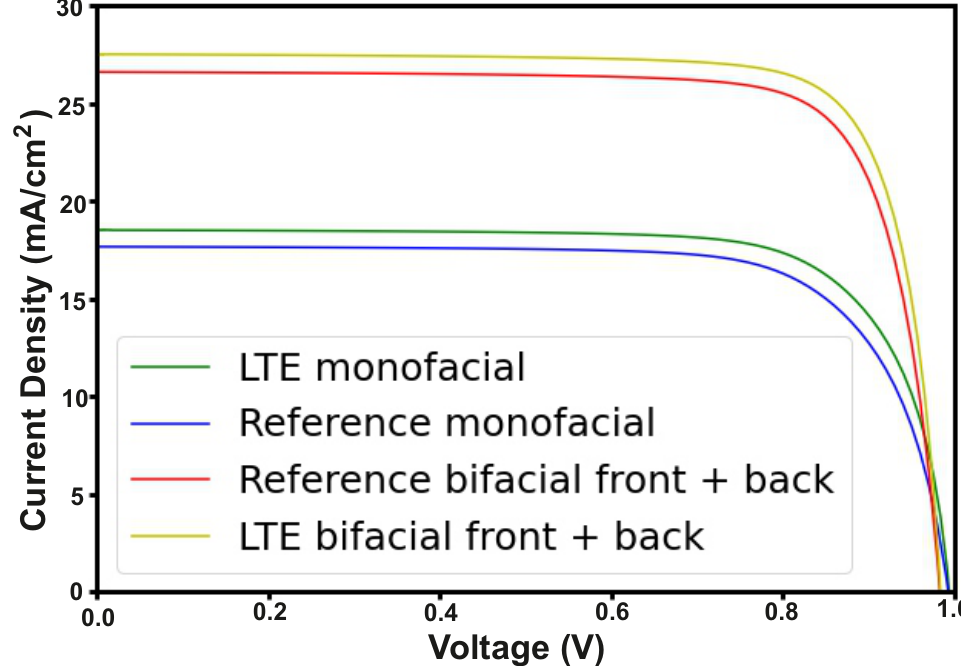
Figure 6. J-V curves for PSCs: monofacial with light-trapping structure(green), monofacial reference (blue), bifacial with light-trapping structure (yellow), bifacial reference (red).